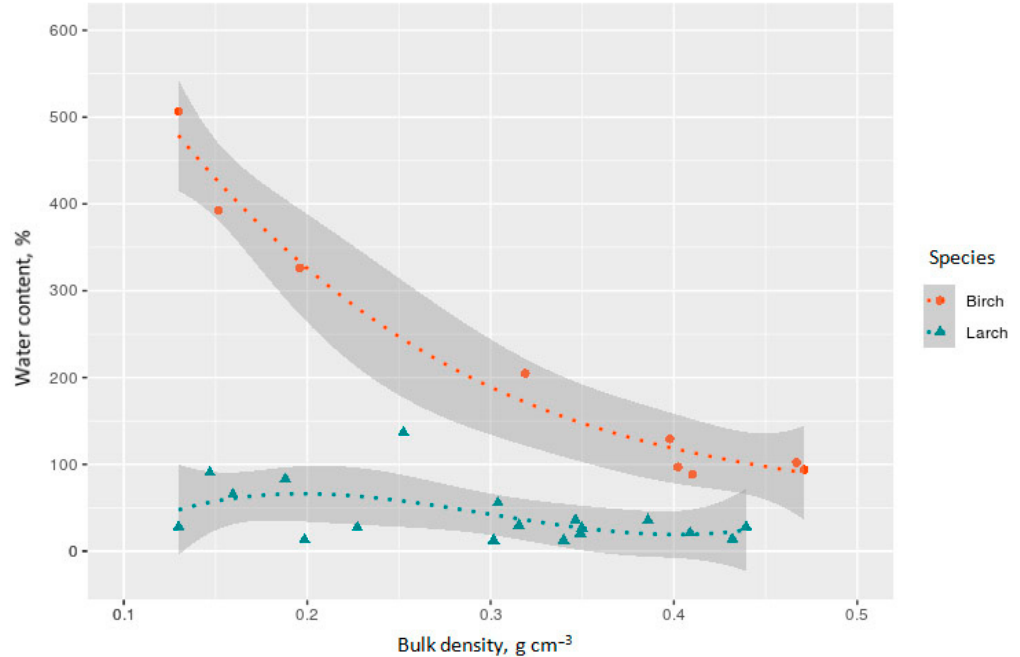
Figure 7. The relationship between bulk density and water content in the decomposed larch and birch wood. Shadowed area indicates the 95% confidence interval of the smooth line.